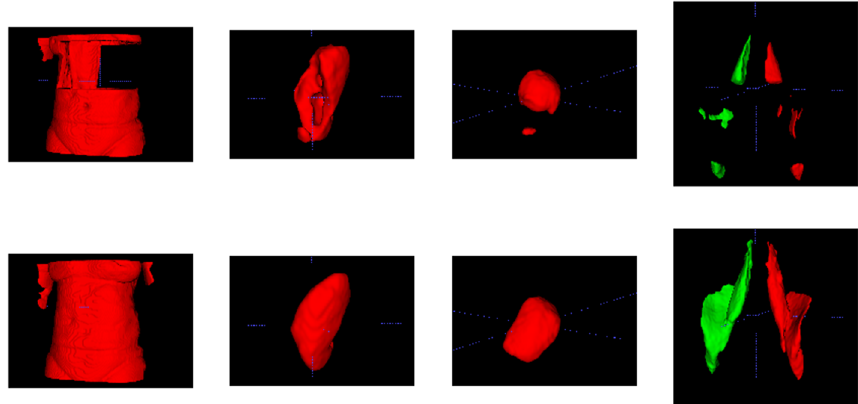
Fig. 6 Impact of fat-water swaps on 3D segmentations. The top row shows segmentations generated using data that contained fat-water swaps and the bottom row shows segmentations of the same tissue and organs using swap-free predictions from our model. From left to right: abdominal subcutaneous fat, left kidney, spleen and iliopsoas muscles (left is red and right is